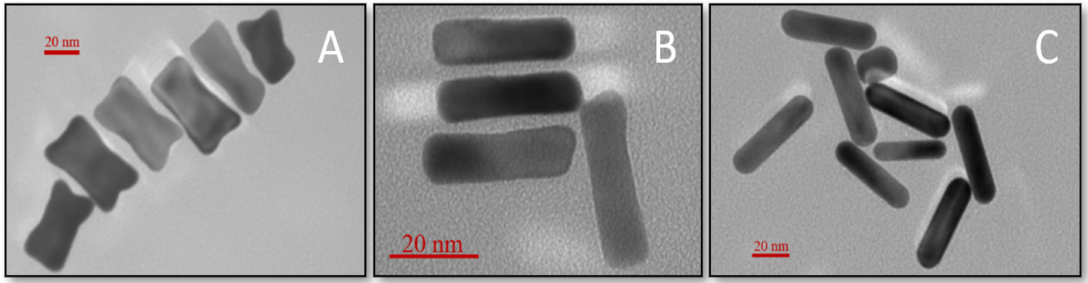
Figure 2. TEM images of synthetized GNBs ( A and B ) and commercial GNRs (sample C ).